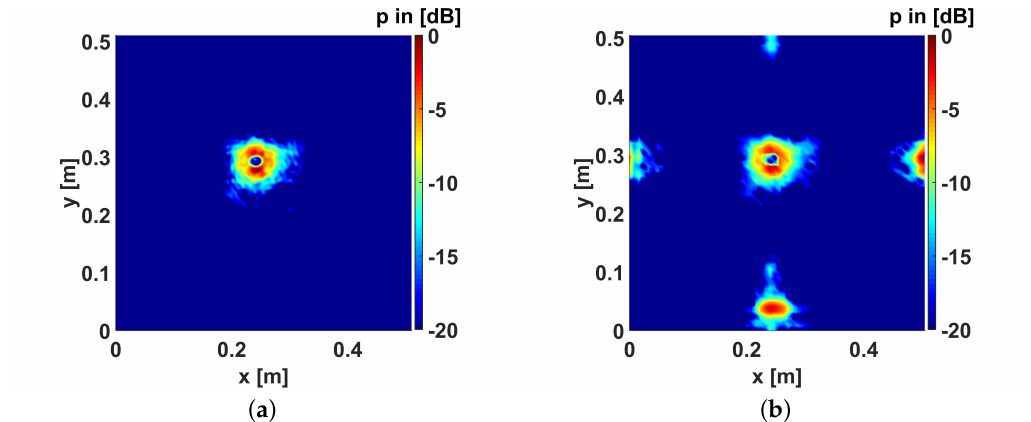
Figure 13. Amplitude at the top of the wooden particleboard with a ø20 mm piece of paper. Evaluated with the re-radiation method for the frequency 48–52 kHz, with ( a ) d x = d y = 2 mm